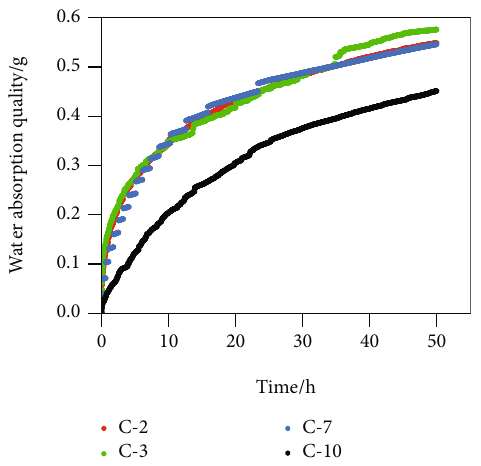
Figure 7: Variation curve of cores imbibition with or without